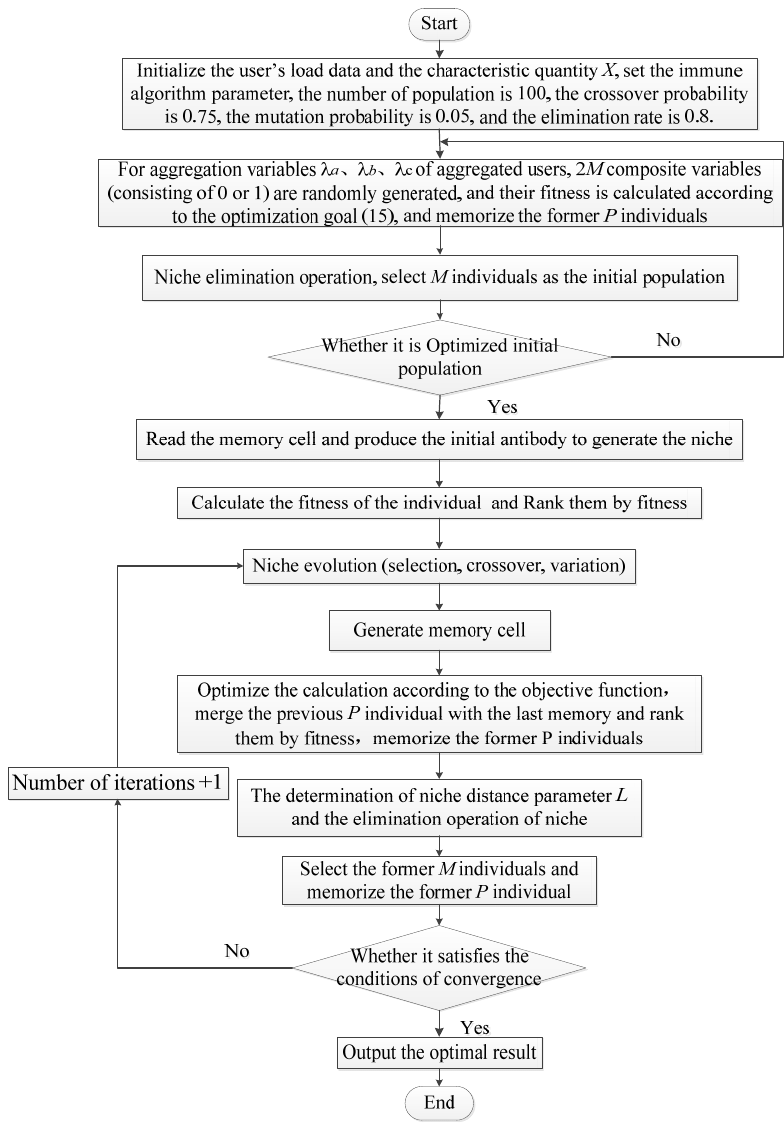
Figure 6. The model solution of the improved dynamic niche evolution multi ‐ objective immune Figure algorithm.